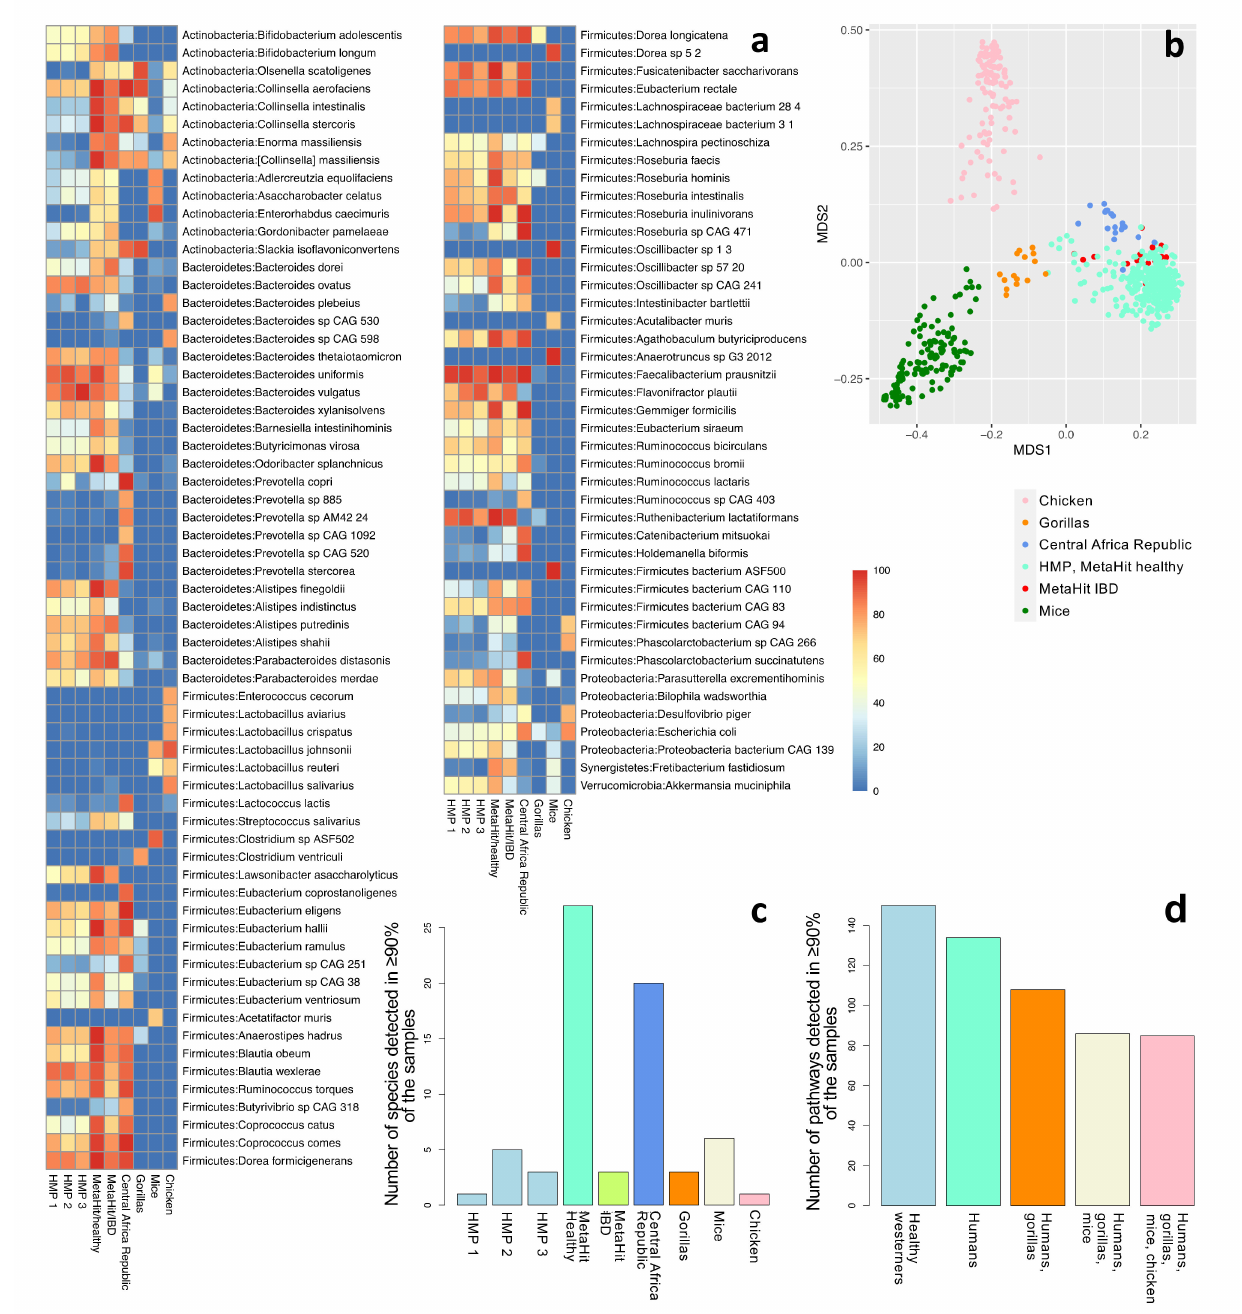
Figure 1. Community profiling of nine cohorts: HMP phases 1 ( n = 138), 2 ( n = 91), and 3 ( n = 42); healthy individuals from Denmark ( n = 64); individuals with IBD from Spain ( n = 16); hunter- gatherers and traditional agriculturalists ( n = 19); gorillas ( n = 15); mice ( n = 141); and chickens ( n = 121). ( a ) The fraction of samples that contain each species, for species detected in at least 70% of the samples in at least one cohort (a total of 107 species). Refer to Supplementary Table S3 for a complete list of all the detected species in all cohorts. ( b ) The first two components of an unweighted UniFrac-based MDS analysis considering all samples. ( c ) The number of species detected in at least 90% of the samples of each cohort. Only one species ( F. prausnitzii ) was detected in 90% or more of the samples across all healthy human Western ( n = 4) and all human ( n = 6) datasets. ( d ) The number of pathways detected in >90% of the samples in all healthy Western human datasets ( n = 4); all human datasets ( n = 6); human and gorilla datasets ( n = 7); human, gorilla, and mouse datasets ( n = 8); and all datasets, including chickens ( n = 9). See also Supplementary Tables S4 and